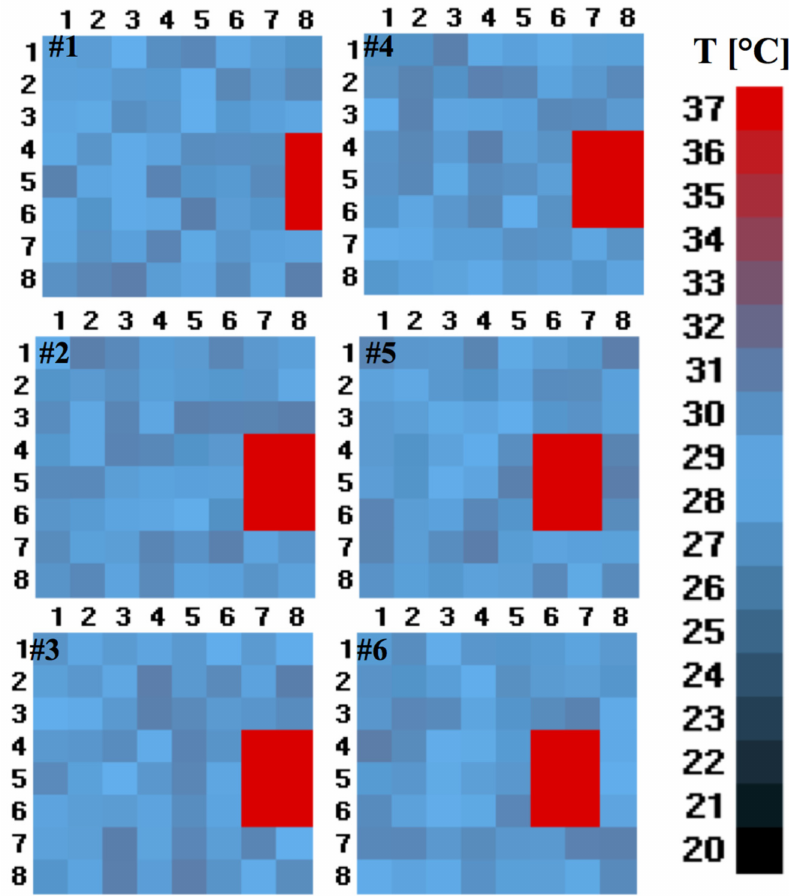
Figure 12. The representative illustration of the random test is shown here. The scenario chosen is when the person is at distance of 5 meters from the sensor and for 26–30 ◦ C temperature